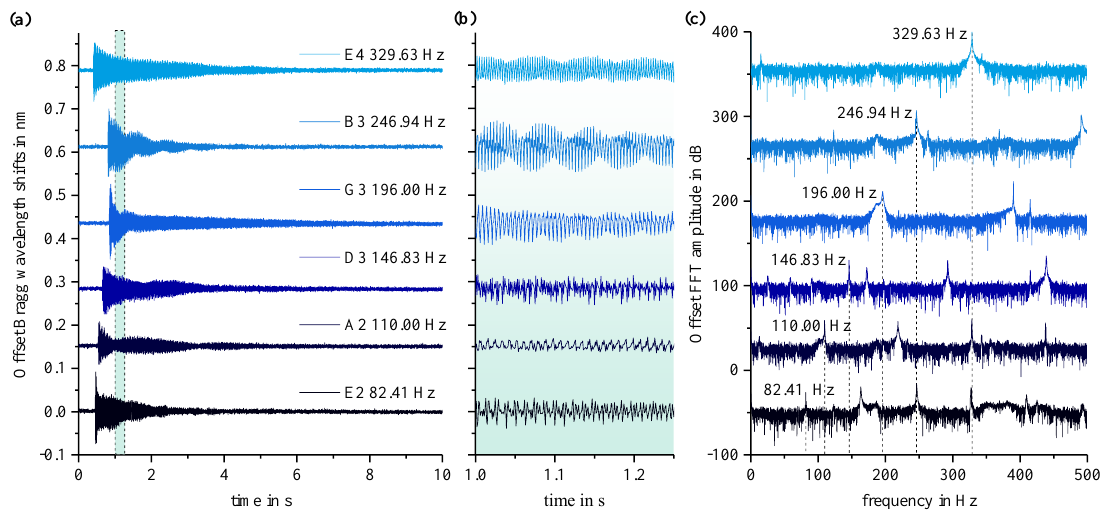
Figure 4. Response of a Bragg grating sensor applied to the flat top of an acoustic guitar. ( a ) Bragg wavelength shifts for plucked guitar strings in standard tuning; ( b ) enlarged view of the sensor’s recorded audio signals; ( c ) Fast Fourier transformation (FFT) spectra of all six signals verifying the fundamental and additional harmonic overtone frequencies.